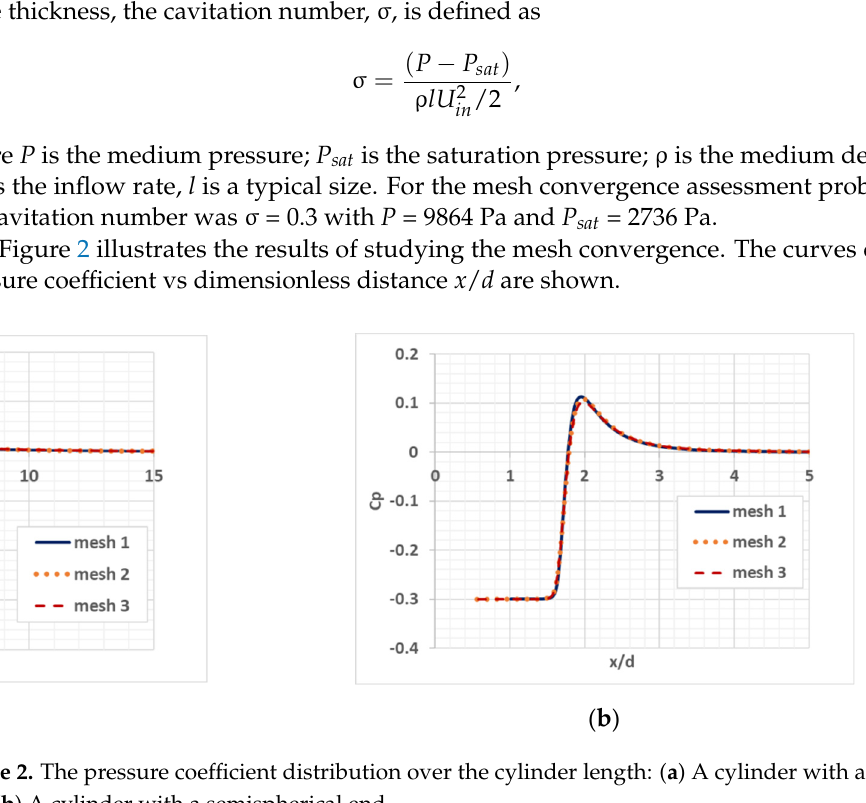
Meshes with semispherical end: mesh 1